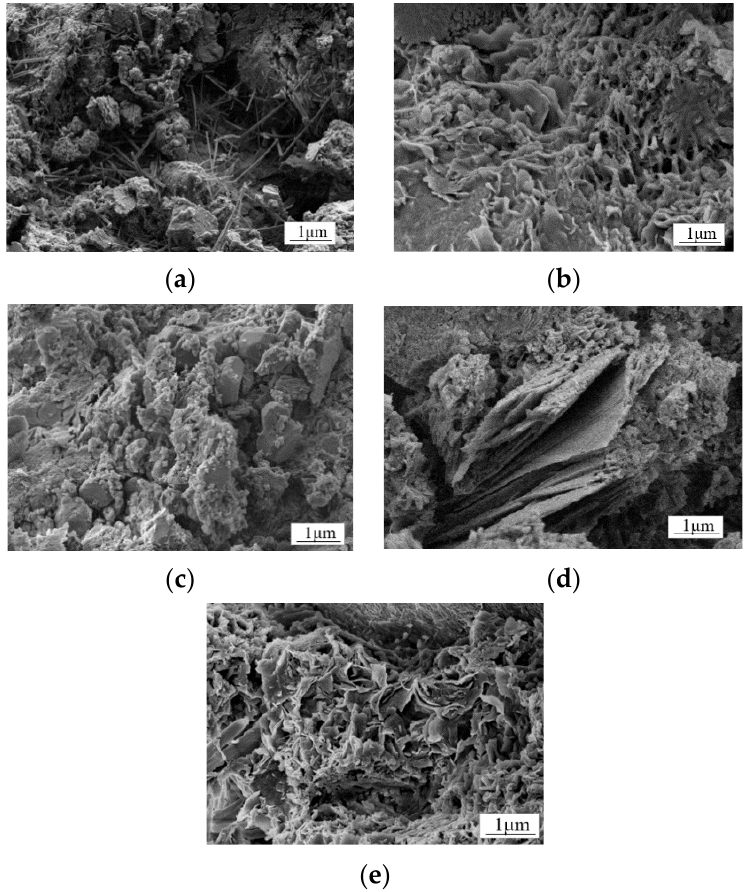
Figure 13. SEM morphology of GO cement matrix composites. ( a ) without GO, ( b ) 0.03 wt% GO dosage, ( c ) 0.05 wt% GO dosage, ( d ) 0.07 wt% GO dosage and ( e ) 0.1 wt% GO dosage.